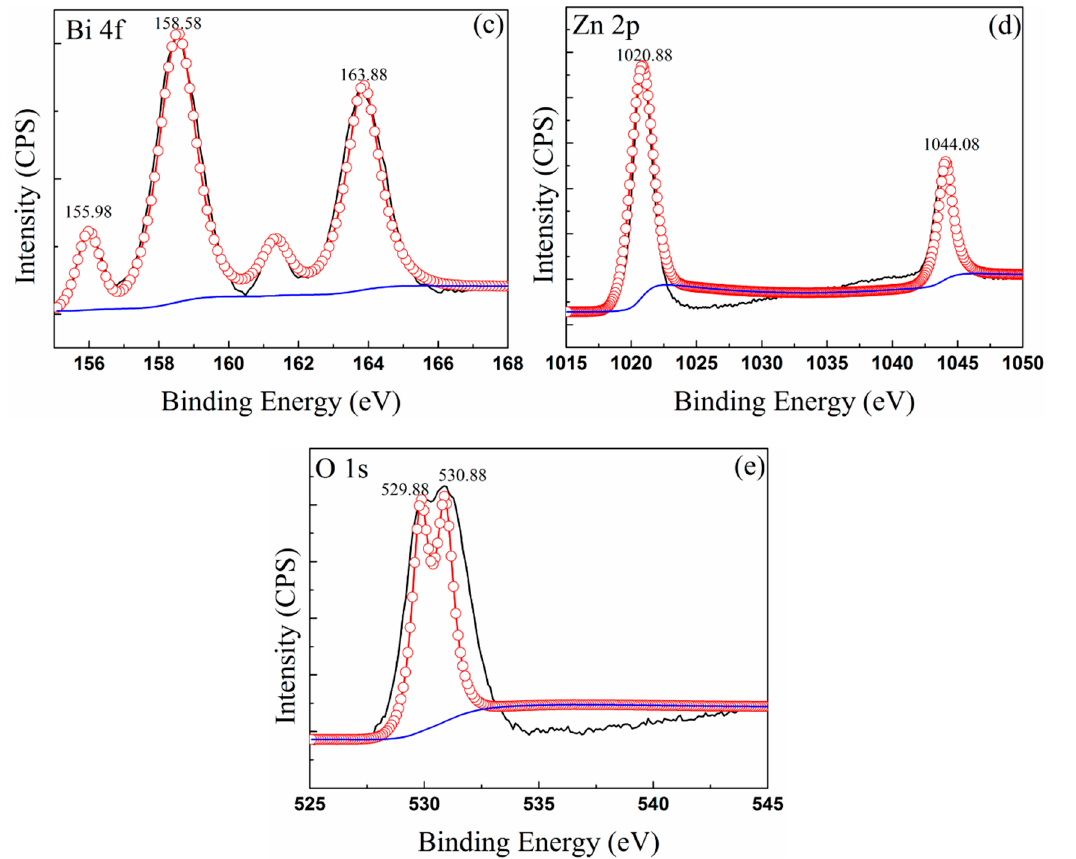
Figure 5. XPS spectra of the Sn–50Bi–2Zn oxide surfaces ( a ), the relevant Sn 3d ( b ), Bi 4f ( c ), Zn 2p ( d ) and O 1s ( e ).